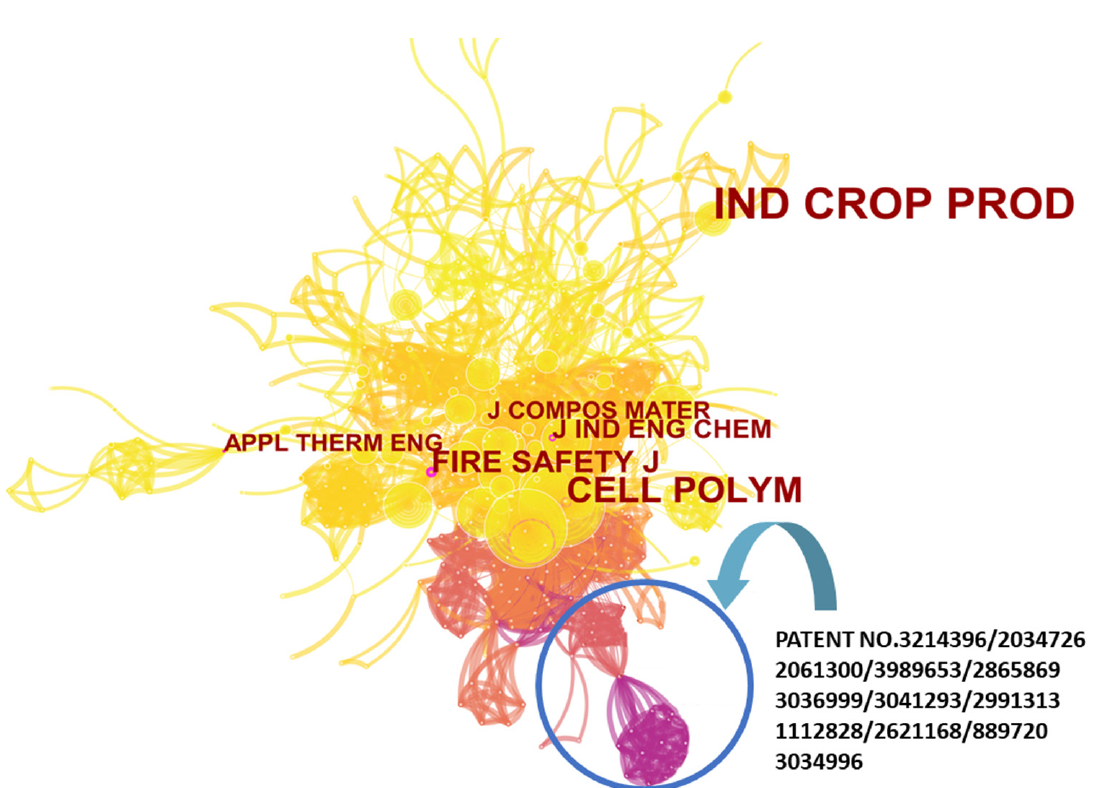
Figure 5. Co-occurrence network of cited journals for flame-retardant RPUF. Table 2. List of journals that have appeared in the co-occurrence network in the last two years.